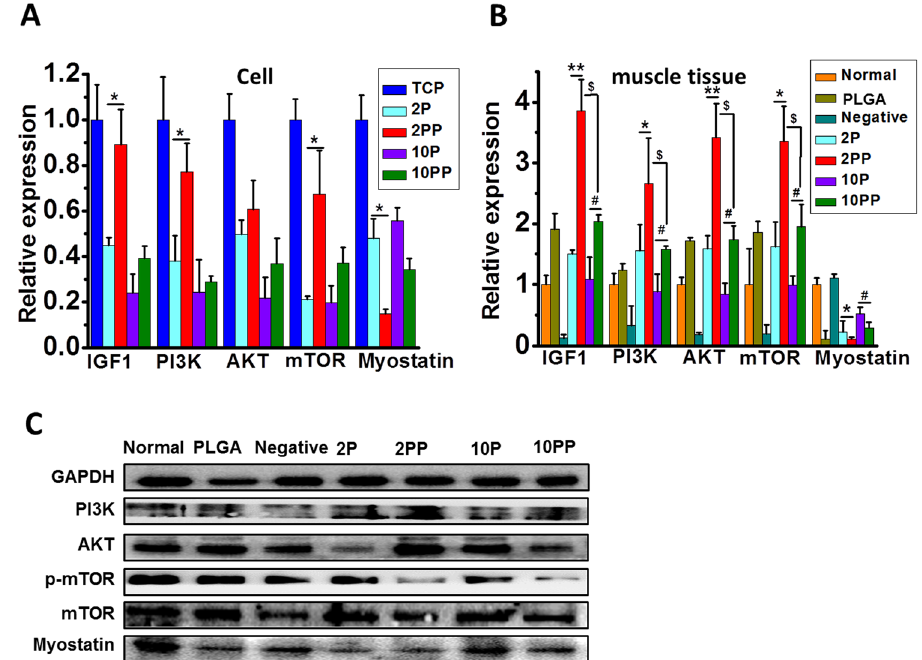
Figure 5. Thinner functionalized electrospun PCL microfibers (2 PP) were more effective for the muscle cell growth and differentiation. ( A , B ) Relative expression of IGF1, PI3K, AKT, mTOR and myostatin of cells and muscle tissues. C, Representative western blotting of PI3K, AKT and myostatin of muscle tissues from in vivo experiments. * , #, $ p < 0.05 and ** p < 0.01 as